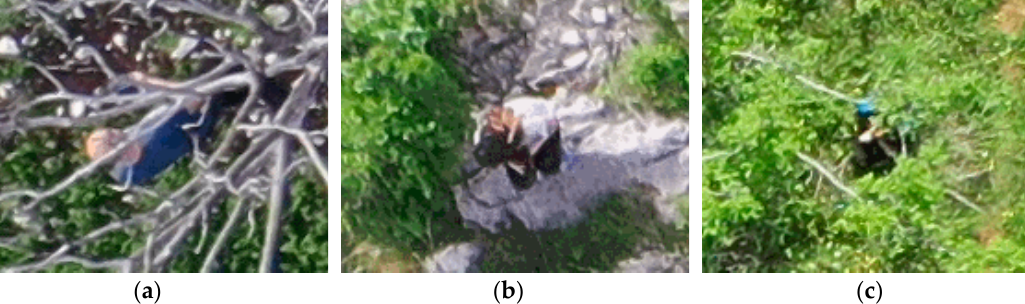
( c ) Figure 12. False-positive examples for the ScoreMap to ROI algorithm: ( a , c ) The algorithm, due to the shadow, made a wrong conclusion, ( b ) The stone and a blue plastic bag create an object that is almost impossible to distinguish from a human. Figure 13 shows the detection results of the participants on the missions with the support of the ScoreMap to ROI algorithm. Figure 14 shows the detection results on missions without support. Figure 15 shows a comparison of missions with the ScoreMap to ROI support and missions without support in terms of recall and precision.